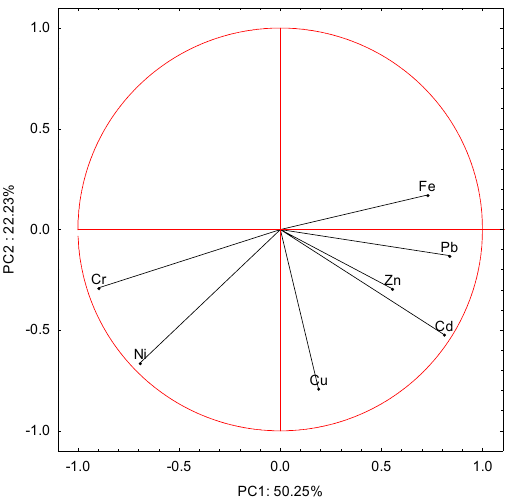
Figure 2. PCA results (position of loadings vectors relative to PC1 and PC2).